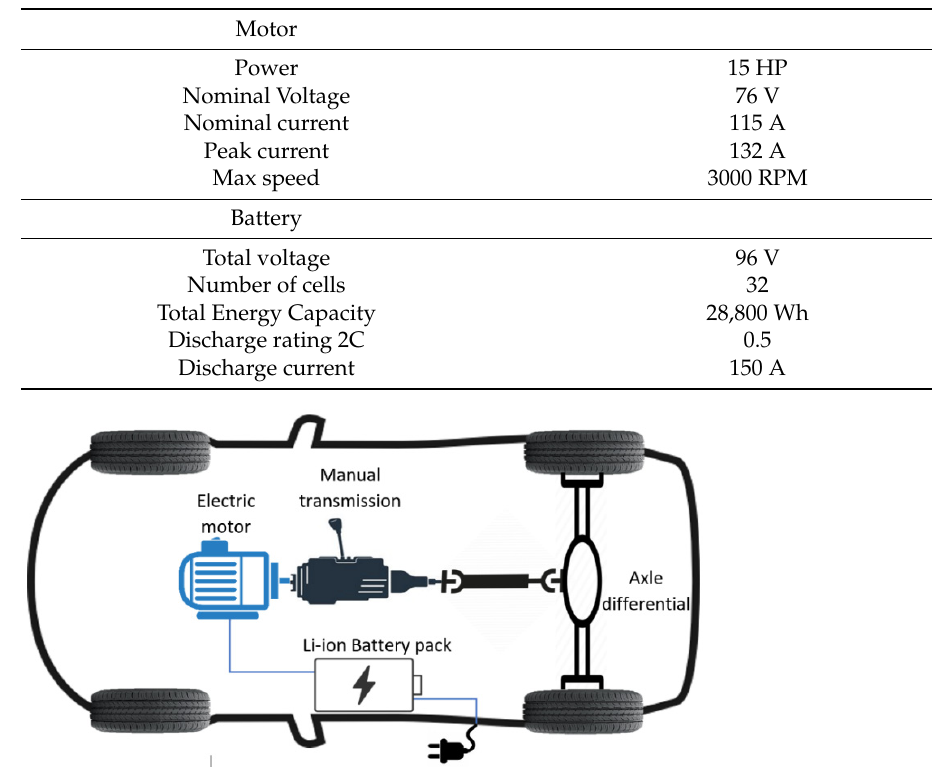
Table 2. Specifications of the test EV’s motor and battery.